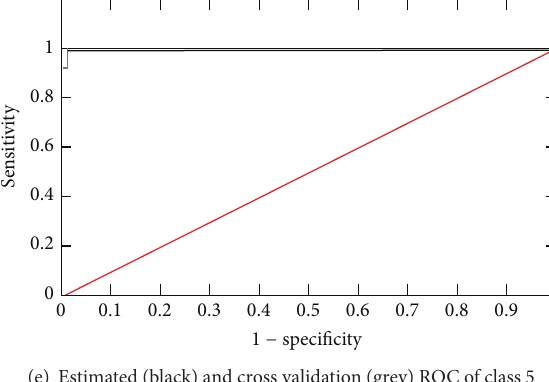
Figure 8: ROC curves of ELM classification model of SEM image samples of the composites in five different aging periods.